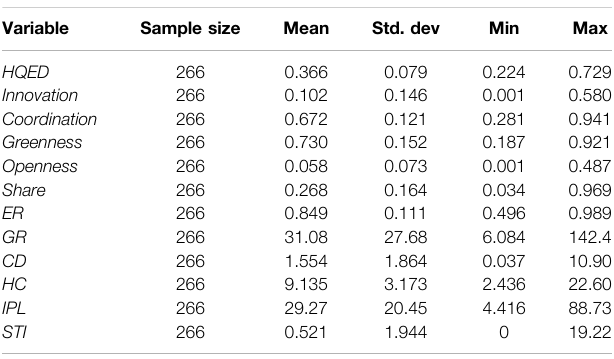
TABLE 3 | Descriptive statistics.